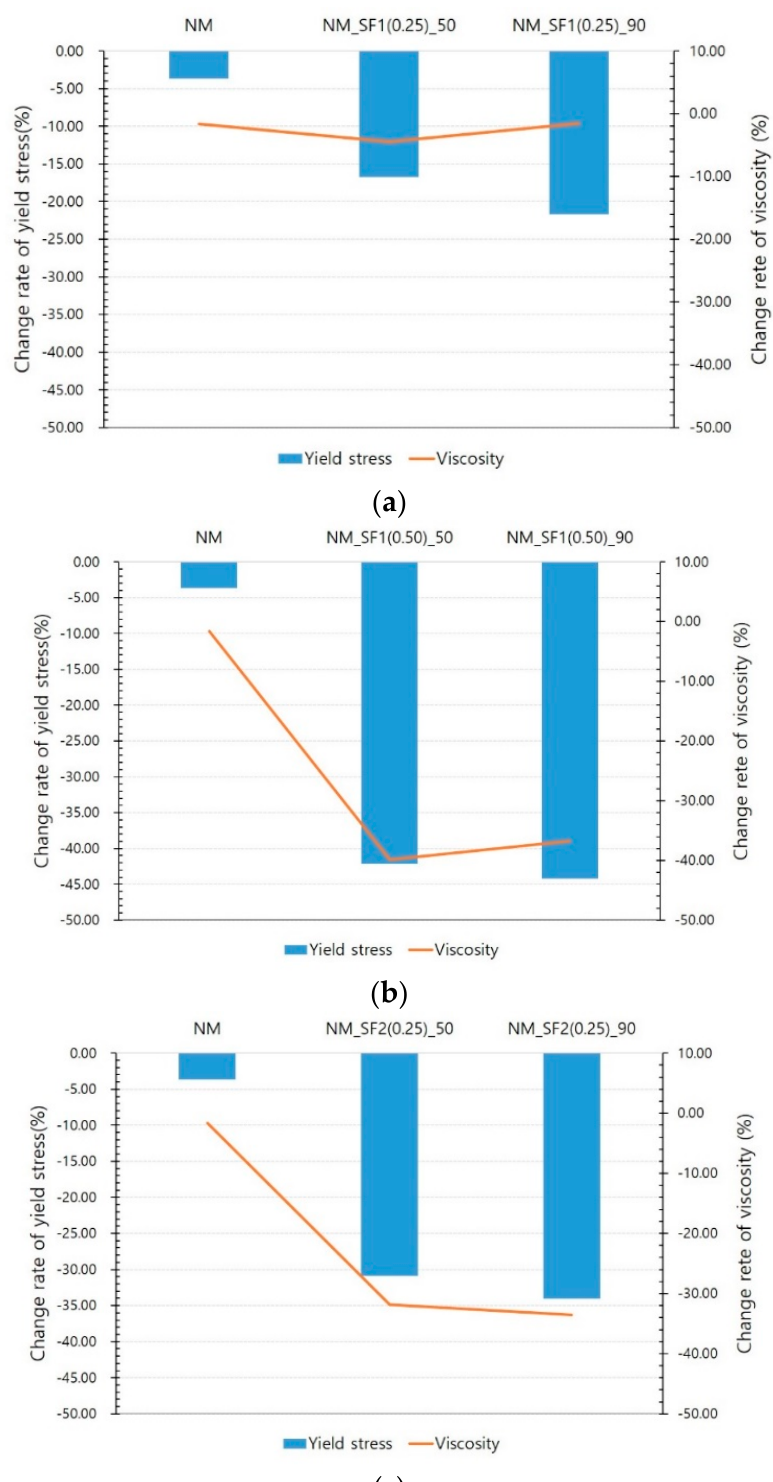
Figure 8. Effect of magnetic flux density: ( a ) NM and NM_SF1 (0.25), ( b ) NM and NM_SF1 (0.50), ( c ) NM and NM_SF2 (0.25).